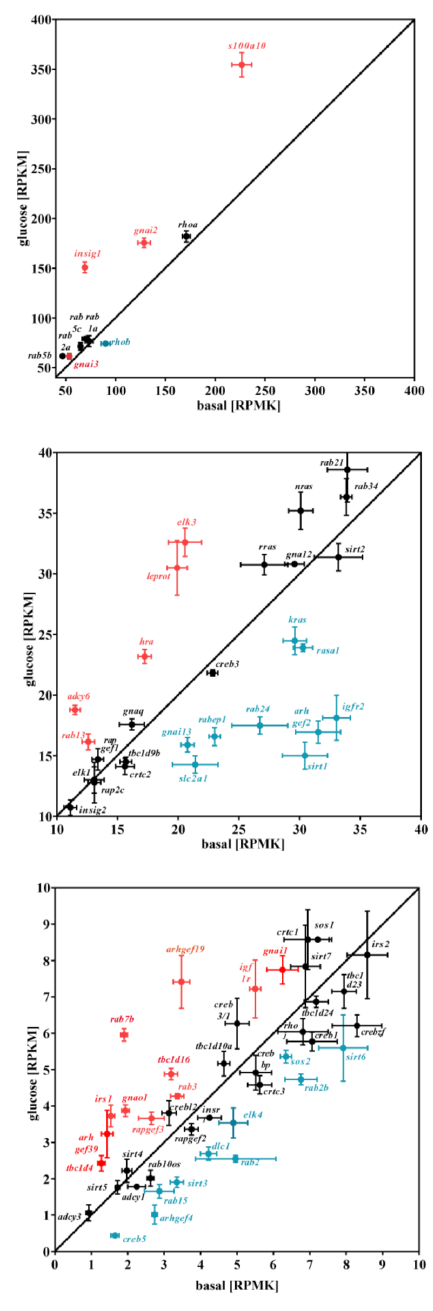
Figure 5. Effects of glucose on mRNA expression of single genes involved in intracellular signal- ing processes in mHypoA-2/10 cells. mHypoA-2/10 cells were stimulated according to protocol 1 illustrated in Section 2.5 and RPKM determined by RNA-seq. For each condition, triplicates from one single experiment (N = 1) were analyzed as described under experimental procedures. RPKM values for 99 genes are given. Genes marked in red were significantly upregulated, and those marked blue were downregulated by glucose (Bonferroni-corrected p -value of ≤ 0.05). Black genes were not significantly affected by glucose. In the lower panel are genes with RPKM between 1 and 10, in the middle panel between 10 and 40, and in the upper panel between 40 and